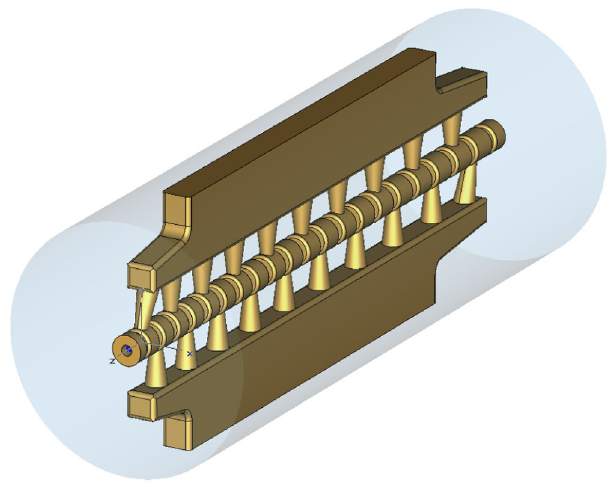
FIG. 11. IH1-tank MWS model. The outer cylindrical wall is removed; cavity inner volume is shown in light